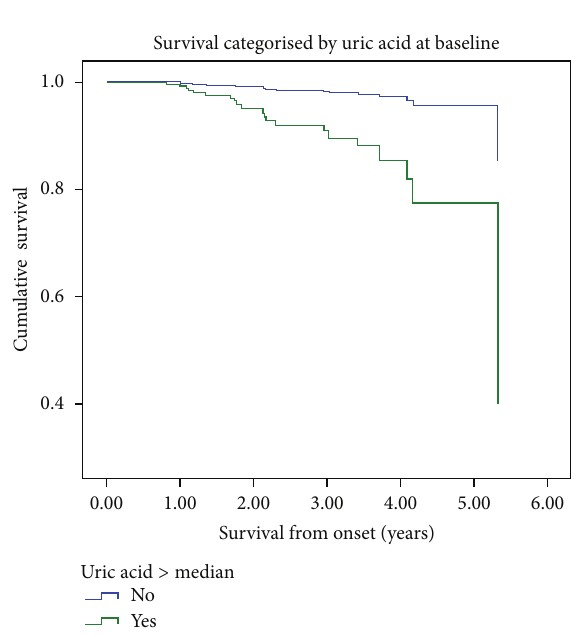
Figure 1: Distribution of patients according to estimated GFR defined by cystatin C and creatinine tertiles. CKD: chronic kidney disease; eGFR creat and eGFR cyst : estimated glomerular filtration rate according to creatinine and cystatin C; T1: tertile 1; T2: tertile 2; T3: tertile 3.